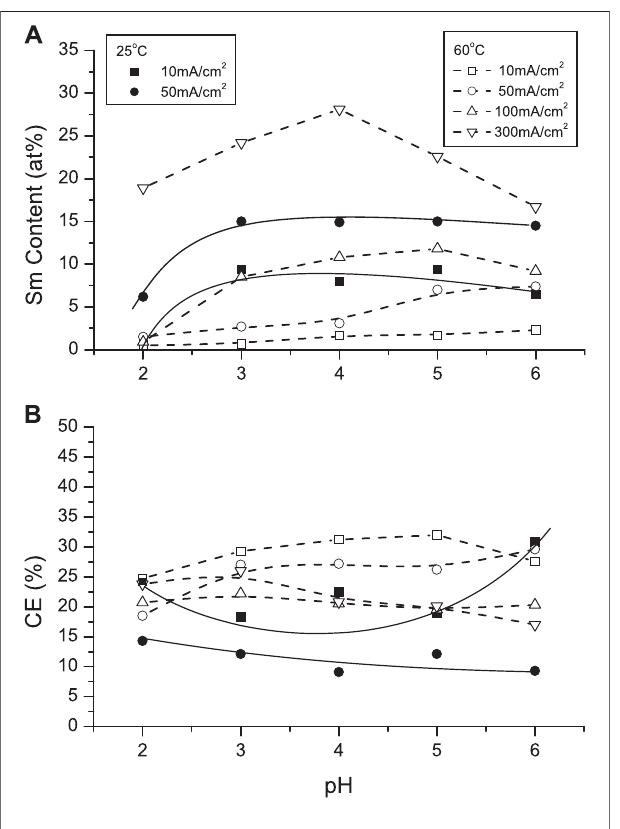
FIGURE 8 | Effect of glycine concentration on (A) samarium deposit content and (B) current ef fi ciency at 25 and 60 ° C.